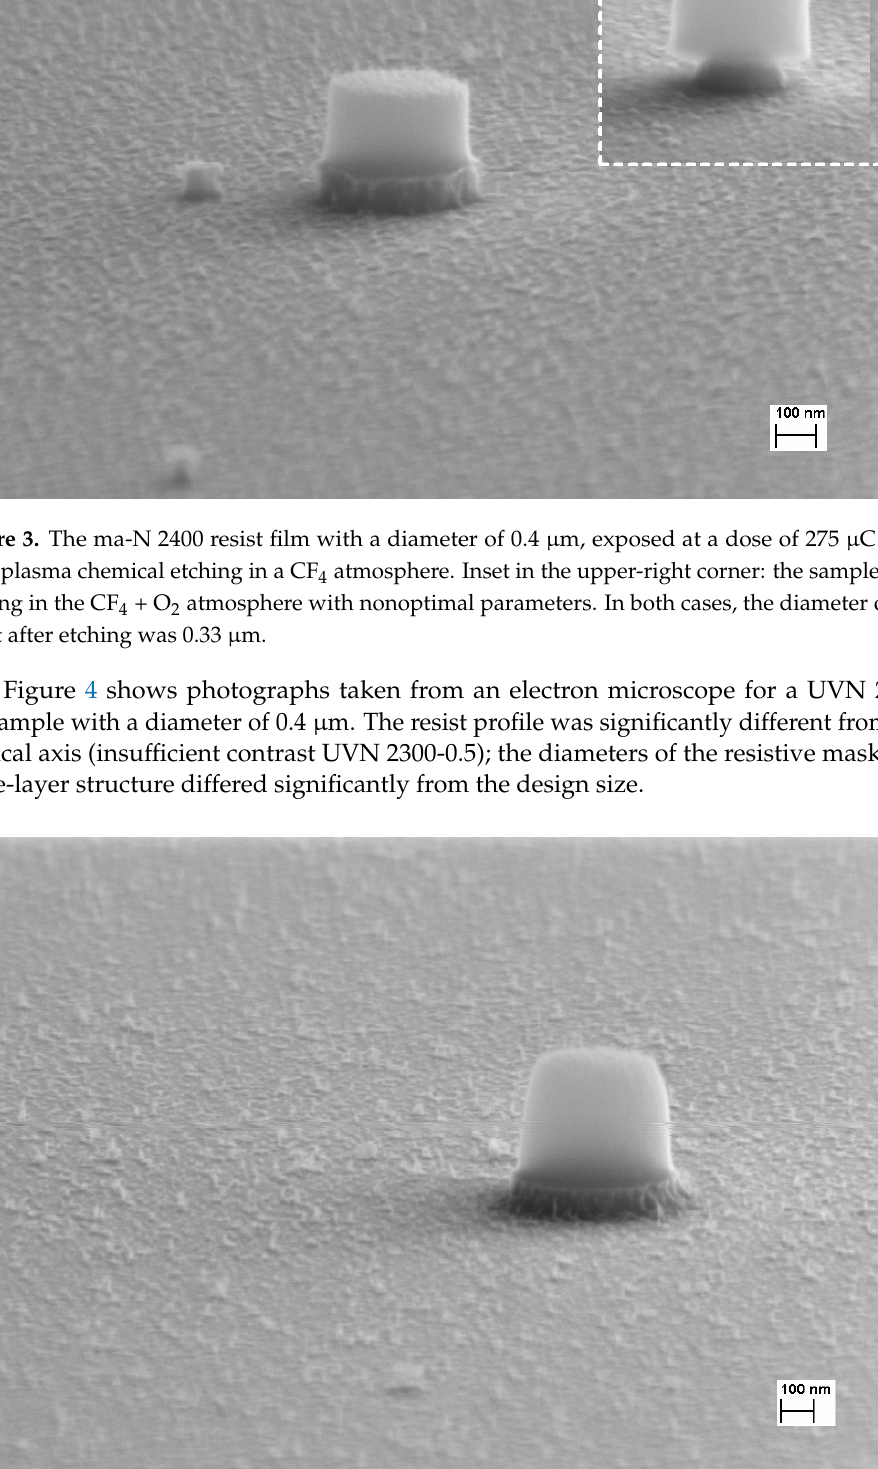
Figure 4. The UVN 2300-0.5 test sample with a diameter of 0.4 µm, exposed at a dose of 20 µC/cm 2 after plasma chemical etching with a resist mask in a CF 4 atmosphere. The diameter of the resistive mask after etching was 0.46 µm; the diameter of the three-layer structure was 0.51 µm.